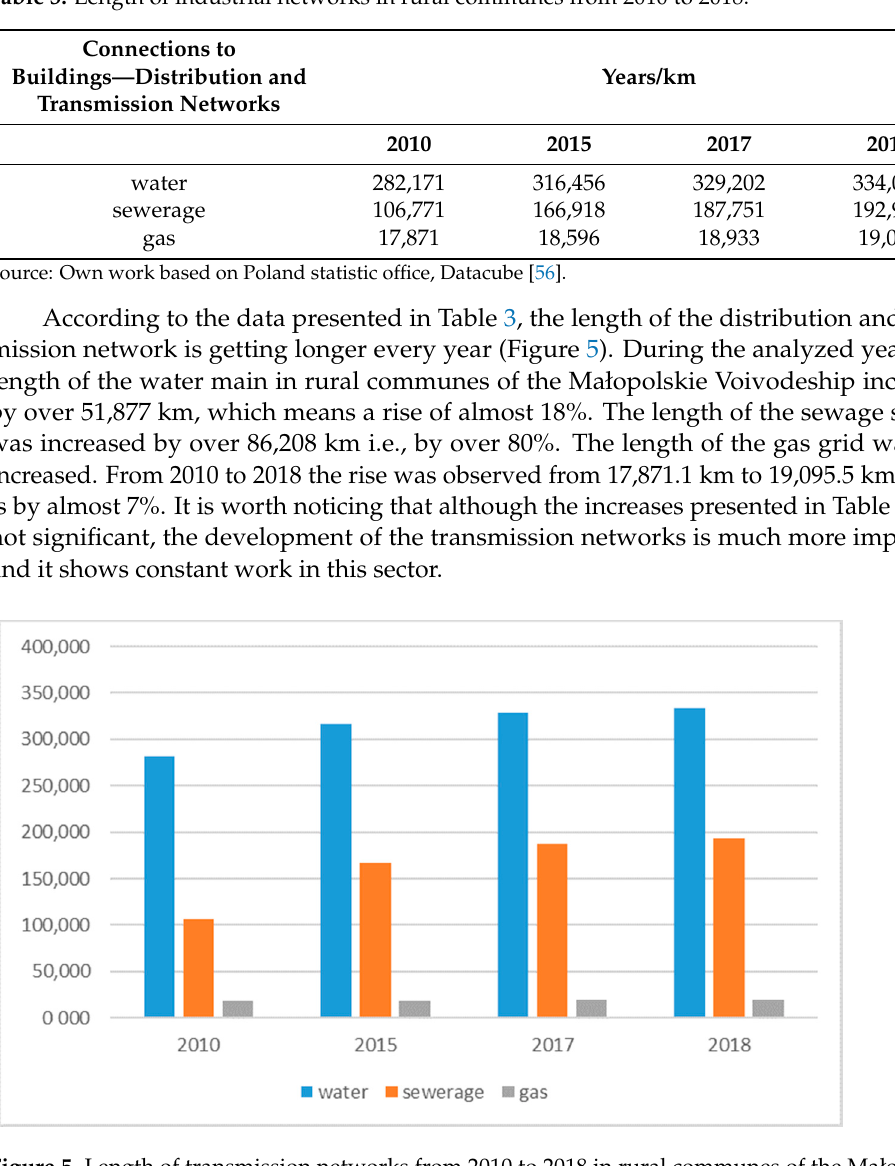
Figure 5. Length of transmission networks from 2010 to 2018 in rural communes of the Ma ł opol- skie Voivodeship in km. Source: Drawn by authors based on Poland statistic office